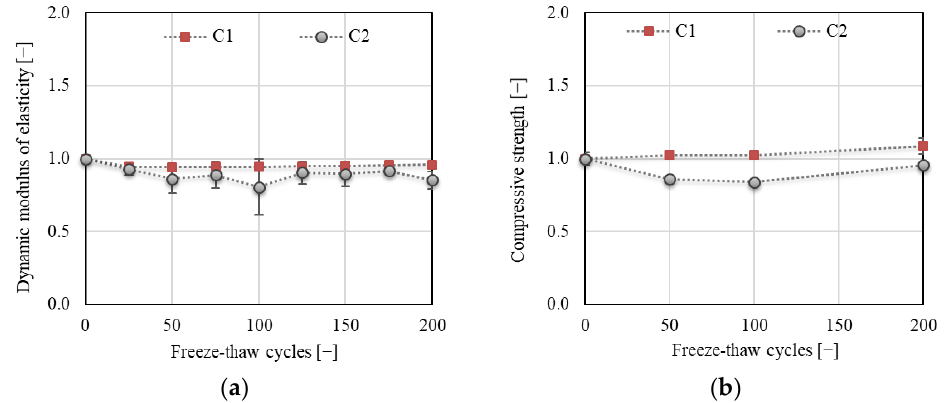
Figure 9. ( a ) Dynamic modulus of elasticity ( E rL ); ( b ) compressive strength.